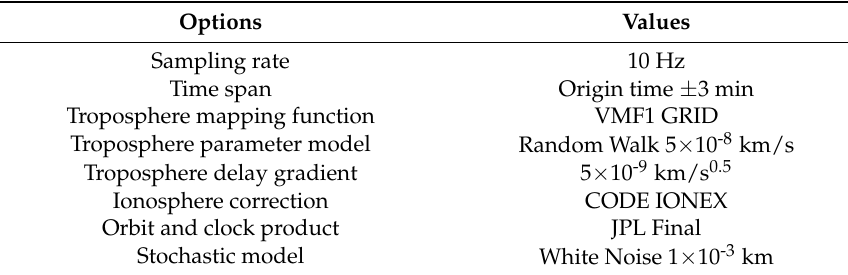
Table 1. High-rate GPS data processing